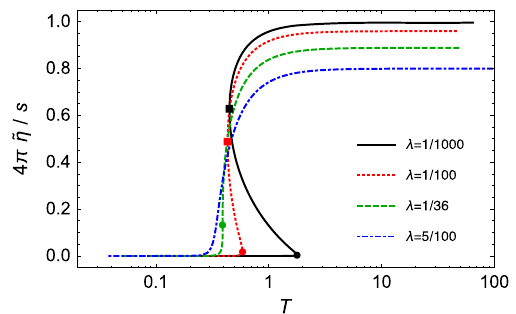
Fig. 2 Global behavior of ˜ η/ s as a function of the temperature for GB BHs with Q = 0 for selected values of the GB coupling constant above,atandbelowthecriticalvalue.Dots(squares)markthemaximum (minimum) of the temperature as a function of the BH